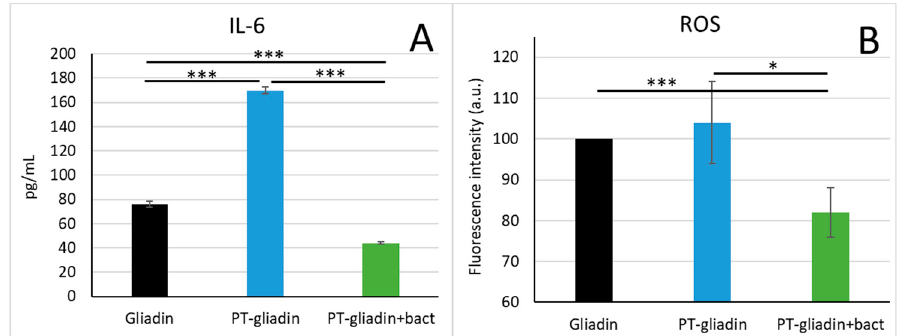
Figure 7. ( A ) Interleukin 6 (IL-6) production in Caco-2 cells stimulated with PMA / ionomycin in the presence of gliadin peptides. Cells were exposed to 1mg / mL PT-gliadin or PT-gliadin + bact, then supernatants of cell culture were analyzed by ELISA. ( B ) Intracellular reactive oxygen species (ROS) as determined by flow cytometry. Cells were exposed to 1mg / mL PT-gliadin or PT-gliadin + bact, stained with cDCF and then analyzed by flow cytometry. * p < 0.05; *** p <0.001.